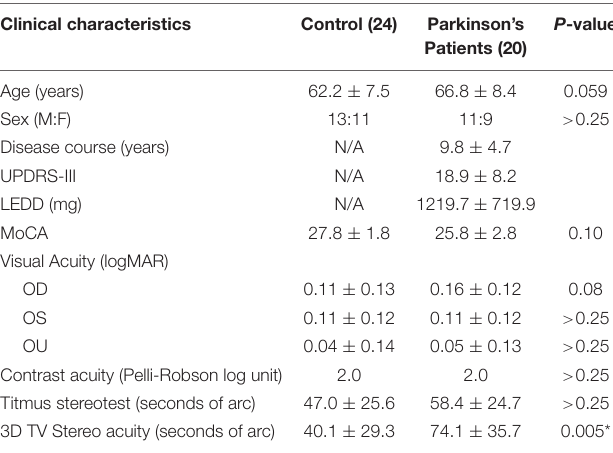
TABLE 1 | Demographic and clinical characteristics of patients with Parkinson’s disease (PD) ( n = 62). Clinical